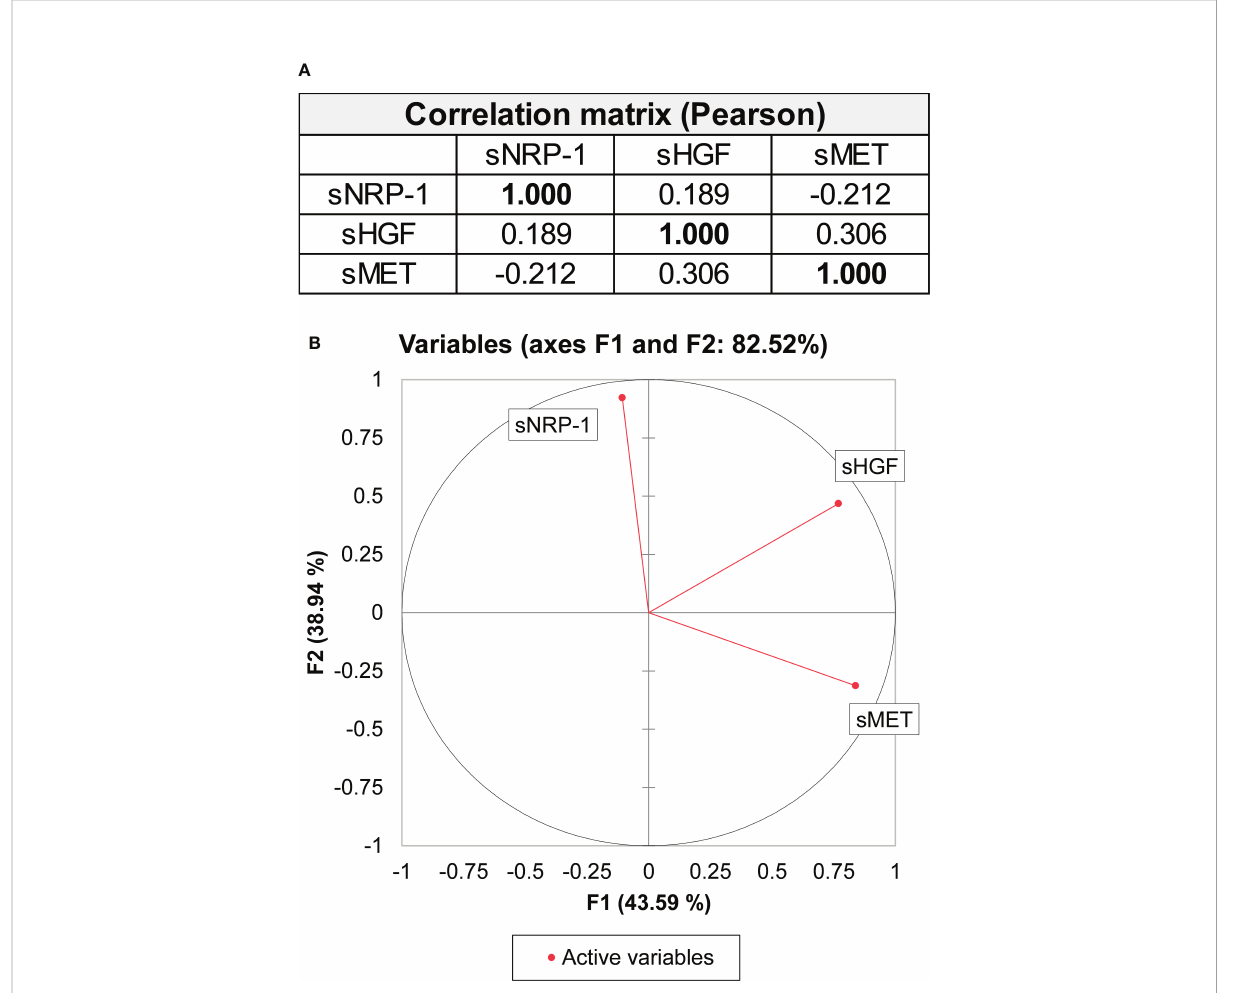
FIGURE 4 Principal component analysis using sNRP-1, sHGF and sMET levels. (A) A correlation matrix as a principal component analysis (Pearson) is shown with sNRP-1, soluble HGF (sHGF) and soluble ectodomain of c-MET (sMET). Values in bold are different from 0 with signi fi cance as p < 0.05. Biomarker levels were measured in blood samples of the same ovarian cancer patient at primary diagnosis. (B) Graphical representation of the principal component analysis of the three variables (sNRP-1, sHGF and sMET) contributing to 82.52% of the variability of the data